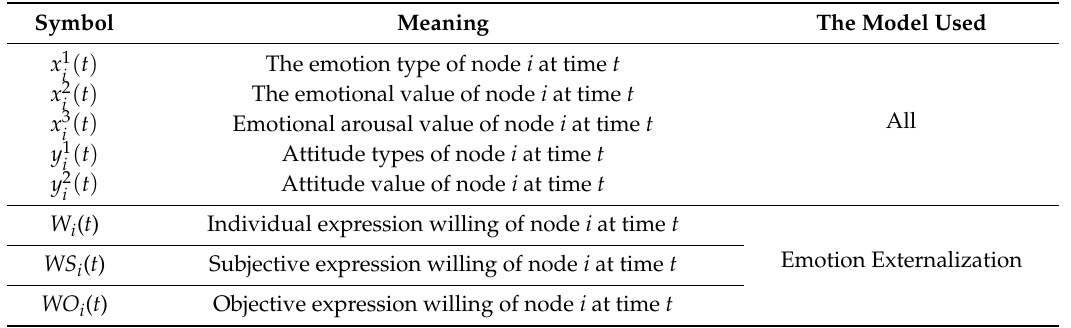
Table 2. Variables involved in the Table 2. variables involved in the model.